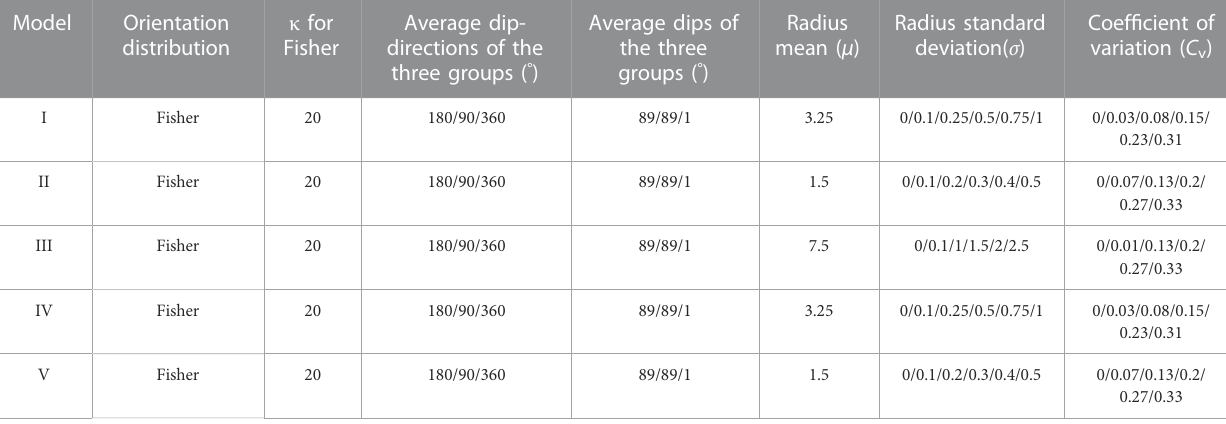
TABLE 2 Parameters of the discrete fracture network models with different means ( μ ), standard deviations ( σ ), and coef fi cients of variation ( C v ). Model